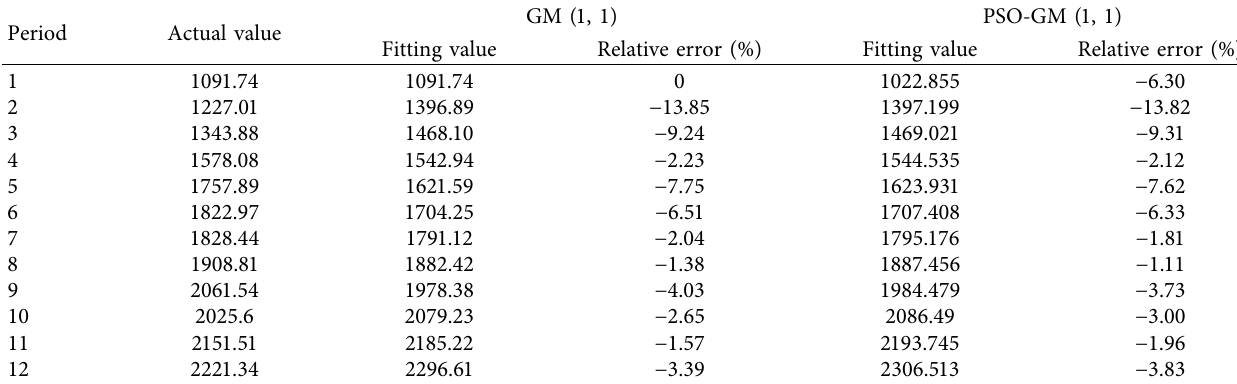
Table 3: Actual value and model fitting value of ZL2-7.